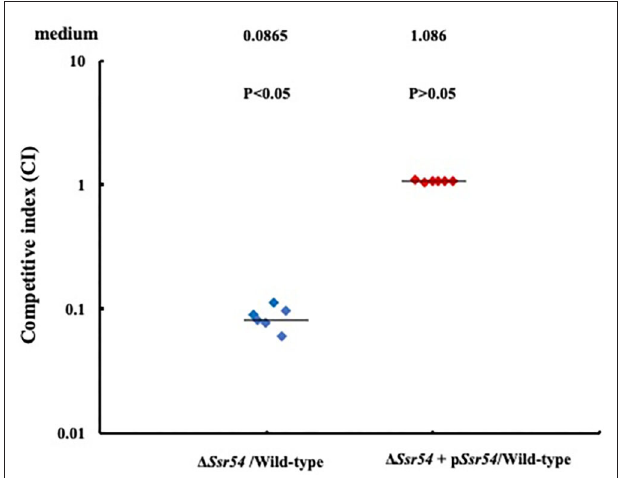
FIGURE 7 | HeLa cell competitive invasion assays of wild-type, mutant 1 Ssr54 , and complement strains. The results show the competitive index (CI) of the Ssr54 mutant. A CI of 1 represents recovery of equivalent amounts of wild-type and mutant bacteria. The CI of the Ssr54 mutant and wild-type was significantly lower than 1 ( P < 0.05); The CI of the Ssr54 complement strain and wild-type was ∼ 1 ( P >